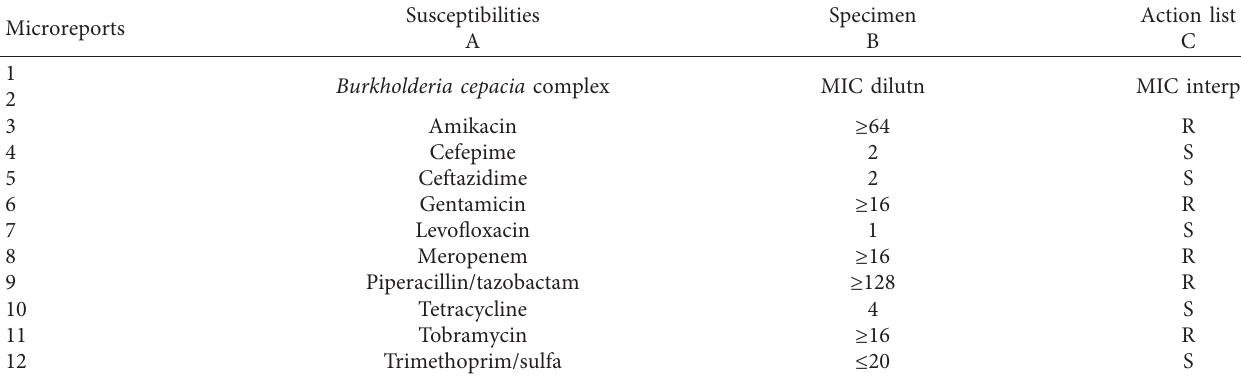
Table 1: Blood culture susceptibilities.